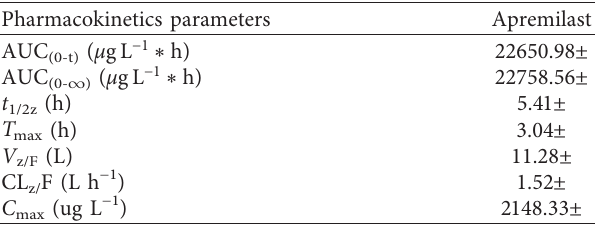
Figure 4: Mean plasma concentration versus time profile of apremilast in beagle dog after its oral administration at 30mg · day − 1 y ( n � Table 3: Pharmacokinetic parameters of apremilast after its single oral administration at 30mg day − 1 in beagle dogs (mean ± SD, n � 5).